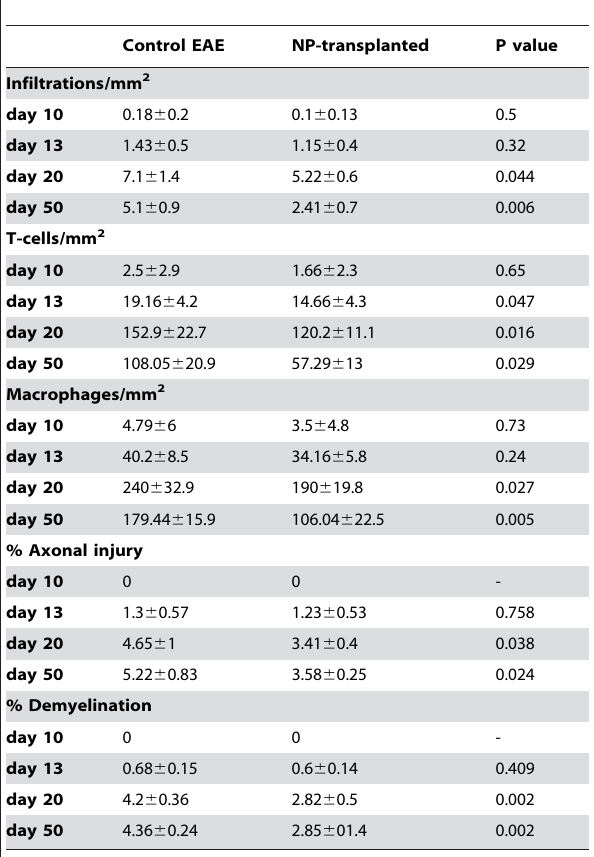
Table 2. Histopathological analyses of inflammatory parameters, demyelination and axonal damage in the spinal cord of C57BL/6 mice at 10, 13, 20 and 50 days after MOG35– 55 EAE